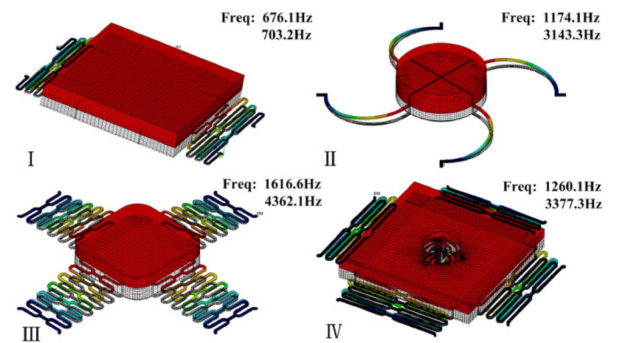
Figure 8. Modal analysis of various microswitches and their first two frequencies. Type I adopted a vertically driven structure with low off-axis sensitivity. Type II and III used a fixed contact point on the proof mass. Type IV realized a longer duration contact with a movable contact